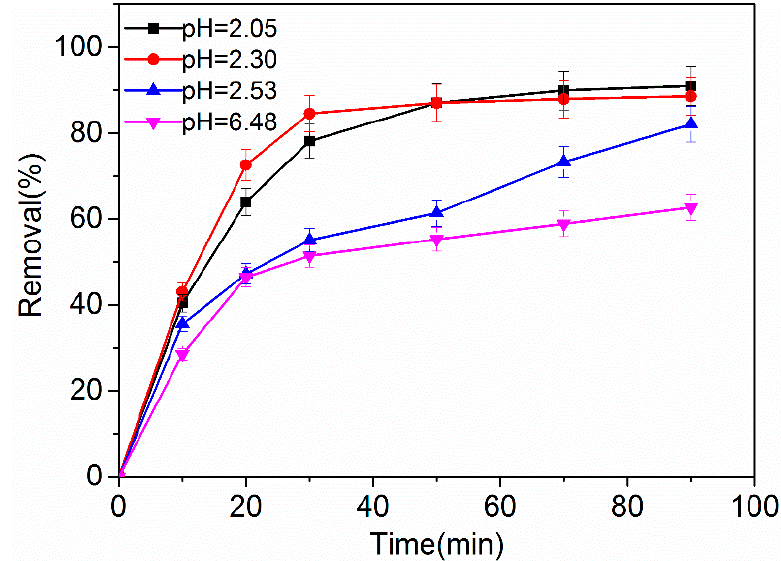
Figure 7. Effect of initial pH on the removal efficiency of 4-CP, I = 6 mA. Figure 7. E ff ect of initial pH on the removal e ffi ciency of 4-CP, I = 6